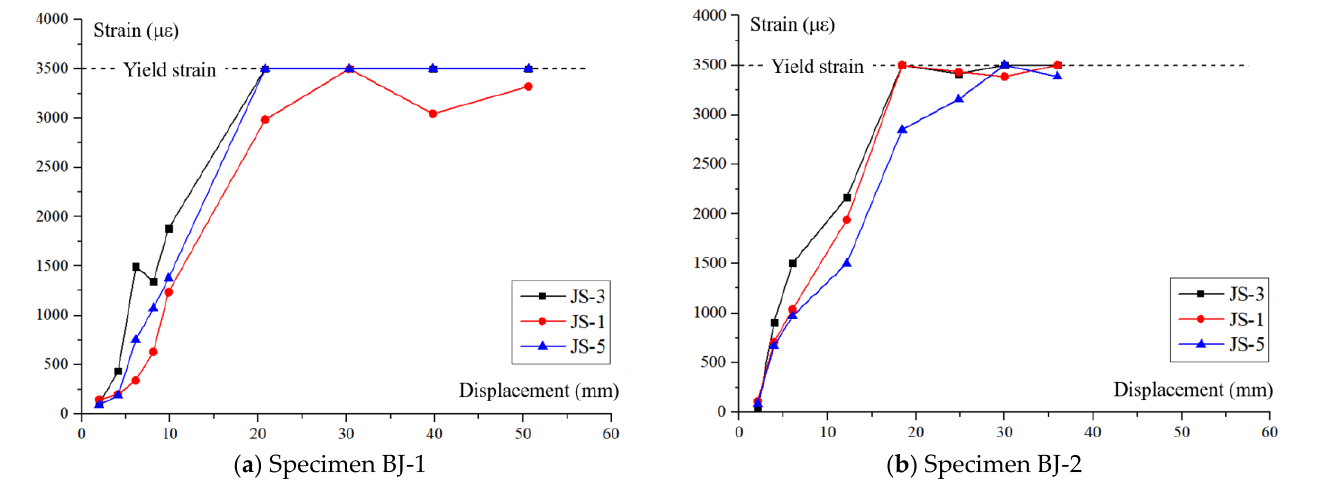
Figure 21. Stirrup strain of side joints.